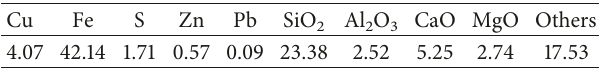
Table 1: Composition of the Ruolanda copper smelting slag (wt.%).